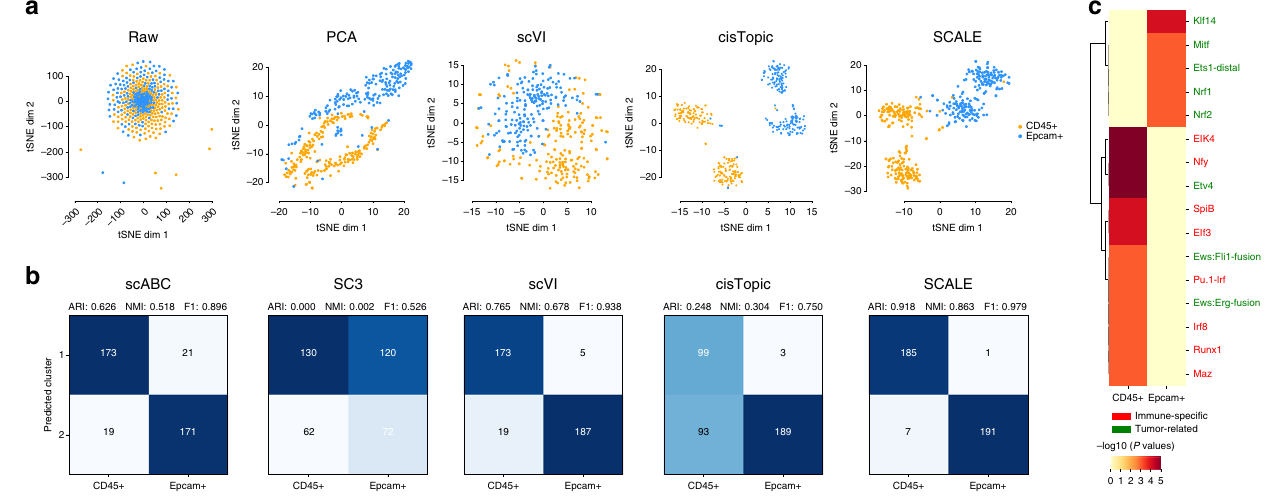
Fig. 4 Application of SCALE on the Breast Tumor dataset from the Pi-ATAC study. a t -SNE visualization of the Breast Tumor raw data, and features extracted by PCA, scVI, and SCALE. b clustering results by scABC, SC3, scVI, cis Topic, and SCALE. c Heatmaps of enriched motifs of different transcription factors across CD45 + cells and Epcam + cells from the mouse breast tumor